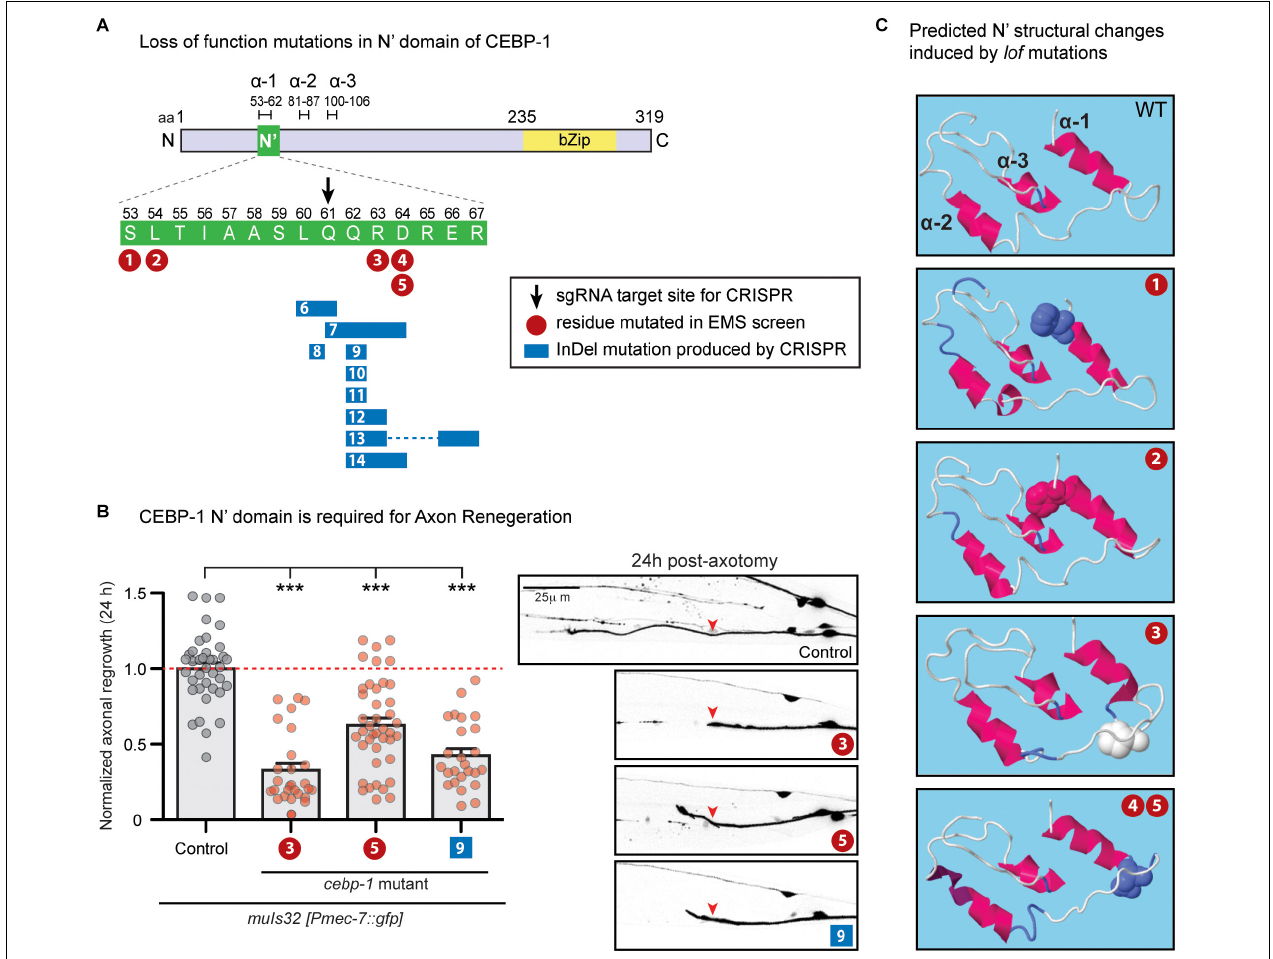
FIGURE 1 | N’ functional domain in CEBP-1 is required for proper axon regeneration and protein structure formation. (A) CEBP-1 N’ domain mutants isolated in several forward genetic screens. Mutations 1–5 are missense mutations isolated in forward genetic screens utilizing EMS as a chemical mutagen. #1, ju1518 S53F; #2, ju1519 L54F; #3, ju634 R63P; #4/5, ju1520/ju1521 D64N. Mutations 6–14 were isolated in a forward genetic screen utilizing targeted CRISPR/Cas9 mutagenesis. The site targeted for double stranded DNA breakage is marked with a black arrow. These mutations do not cause a shift in frame, only add and/or delete amino acids adjacent to the cut site. #6, ju1588 (cid:49) (L60, Q61); #7, ju1587 (cid:49) (Q61, Q62, R63, D64) +HH; #8, ju1592 L60[HSTRS]Q61; #9, ju1590 (cid:49) Q62; #10, ju1685 (cid:49) Q62 +HE; #11, ju1686 (cid:49) Q62 +HRG; #12, ju1591 (cid:49) (Q62, R63) +RPVTS; #13, ju1586 (cid:49) (Q62, R63)+H (cid:49) (E66, R67); #14, ju1589 (cid:49) (Q62, R63, D64)+H. (B) PLM axon regrowth 24 h post-axotomy in cebp-1(ju634) mutants in PLM mechanosensory neurons. Length of regrowth was quantified by subtracting the initial length of the axon at 0 h from the length of the axon 24 h after injury. Data are shown as mean ± SEM. One-way ANOVA followed by Tukey’s multiple comparison test. ∗∗∗ p < 0.001. Column 1: control, CZ10969 [ muIs32 ]; Column 2: CZ21689 [ muIs32; cebp-1(ju634) ] (#3); Column 3: CZ27204 [ muIs32; cebp-1(ju1521) ] (#5); Column 4: CZ27464 [ muIs32; cebp-1(ju1590) ] (#9). Right: representative images of PLM axons 24 h post-axotomy. Red arrowhead, site of axotomy. (C) Alteration of predicted alpha helices structure upon cebp-1 N’ mutations based on RaptorX. The S53F mutation (#1) makes a predicted break in α -2, producing two helices. The L54F mutation (#2) makes lengthening of α -1 and α -2, and the R63P mutation (#3) makes lengthening of α -2. The D64N mutation (#4/5) is predicted to cause the additional turn in the C’ end of α